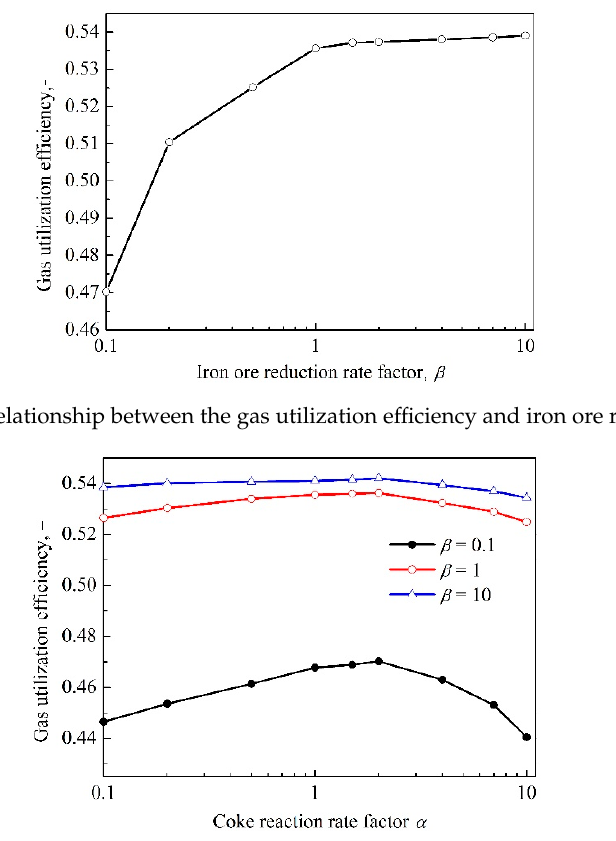
Figure 8. The relationship between the gas utilization efficiency and coke reactivity under different iron ore iron ore reducibility.